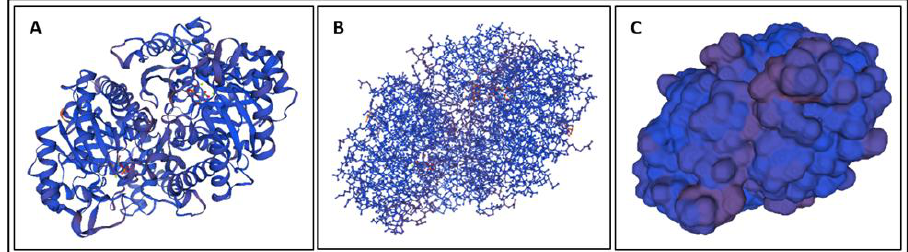
Figure 9. ( A ) A cartoon model, ( B ) a ball-and-stick model, and ( C ) a surface model of NSE made using amino acid sequences from the UniProt database [38].